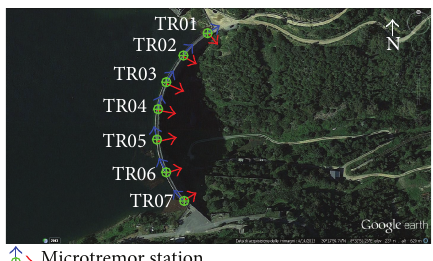
Figure 3: In-contact sensor stations placed on the dam crest.